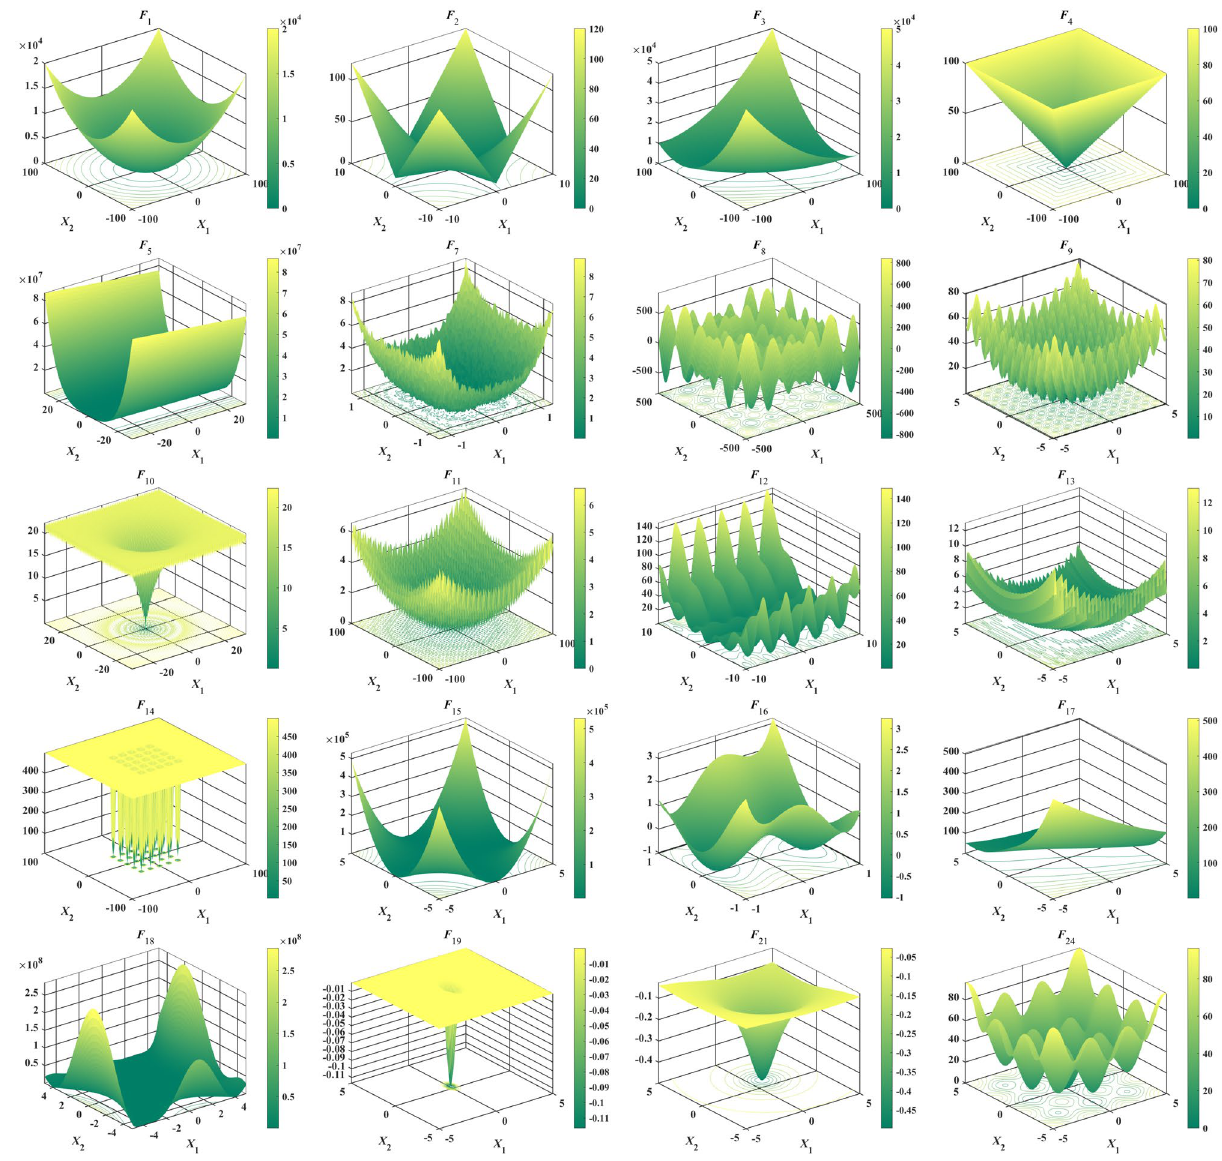
Figure 4. A 2D shape of classical benchmark